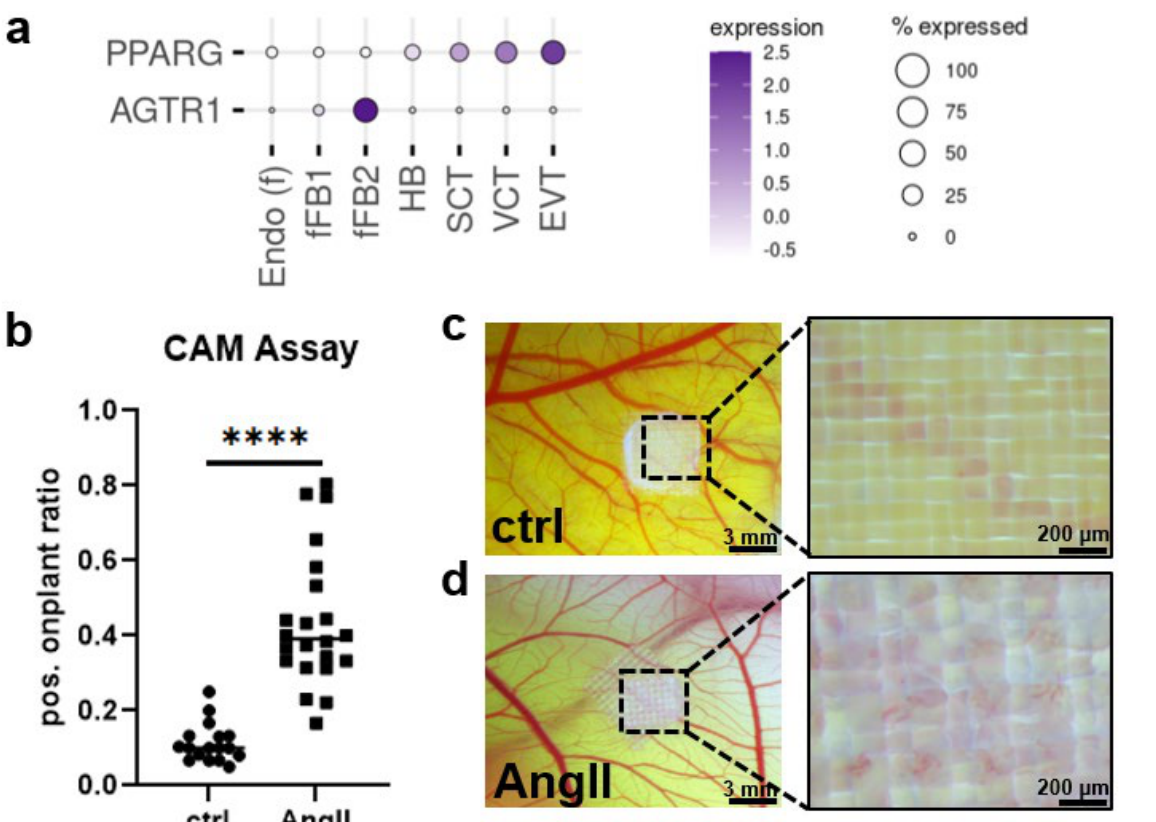
Figure 4. Candesartan target AGTR1 is expressed in fetal myofibroblasts. ( a ) Expression pattern of possible binding sites for AGTR1-blocker candesartan at the maternal–fetal interface in the human first trimester placenta (single-cell RNA sequencing data from Vento-Tormo et al. published 2018 in Nature [33]). ( b ) Chicken chorioallantoic membrane (CAM) assay showed significantly increased on-plant vessel outgrowths ( n = 4, unpaired t -test, **** p < 0.0001; scale bar in left panels represents 3 mm, in right panels 200 µm) when treated with 0.1 µM angiotensin II (AngII) for 24 h ( d ) as compared to DMSO controls ( c ).